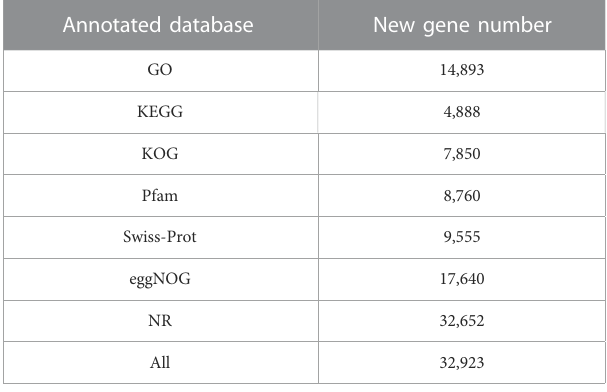
TABLE 1 Functional annotation of all new genes identi fi ed in RNA-Seq. Annotated